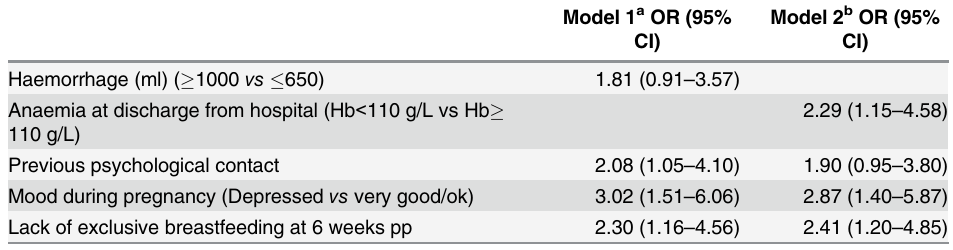
Table 3. Multivariate logistic regression derived odds ratios (ORs) and 95% Confidence Interval (95% CI) for self-reported depression status (EPDS (cid:1) 12) at 6 weeks postpartum.